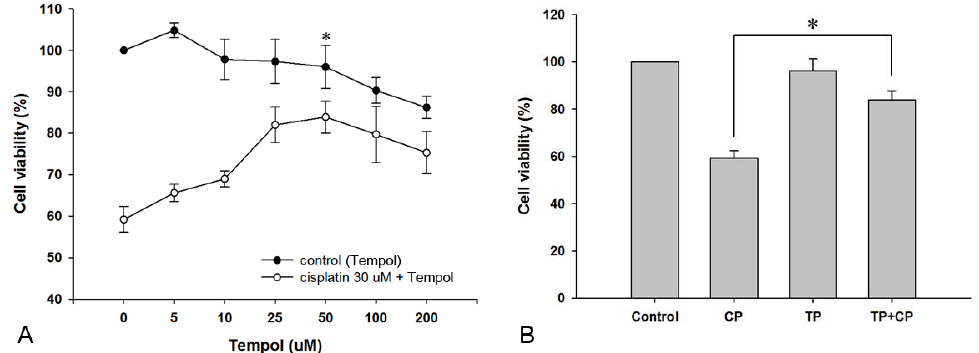
Figure 1. Effect of Tempol on the viability of House Ear Institute-Organ of Corti 1 (HEI-OC1) cells. Cell viability was not significantly affected at concentrations ≤ 50 μ M Tempol. However, concentrations of 100 and 200 μ M Tempol decreased cell viability significantly compared to the viability of the control cells (filled circles). HEI-OC1 cells were pretreated with different concentrations of Tempol for 2 h and then exposed to 30 μ M cisplatin for 24 h (empty circles). HEI-OC1 cells were maximally protected by treatment with 50 μ M Tempol. * Optimal experimental concentration of Tempol ( A ). HEI-OC1 cells were pretreated with 50 μ M Tempol for 2 h and then exposed to 30 μ M cisplatin for 24 h. Tempol exerted a significant protective effect against cisplatin cytotoxicity ( B , * p < 0.05; paired Student’s t -test). Each group was tested in triplicate. CP, cisplatin; TP,